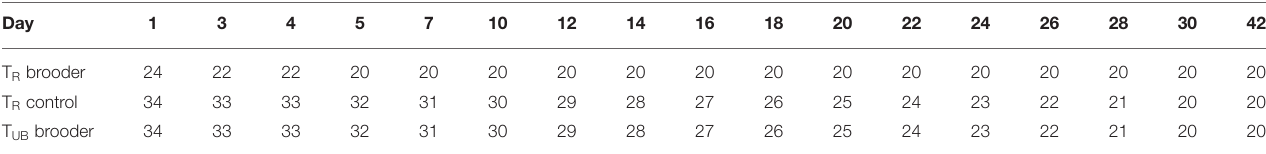
TABLE 1 | Schematic overview of the room temperatures used for control and dark brooder groups and the temperature under the dark brooders.